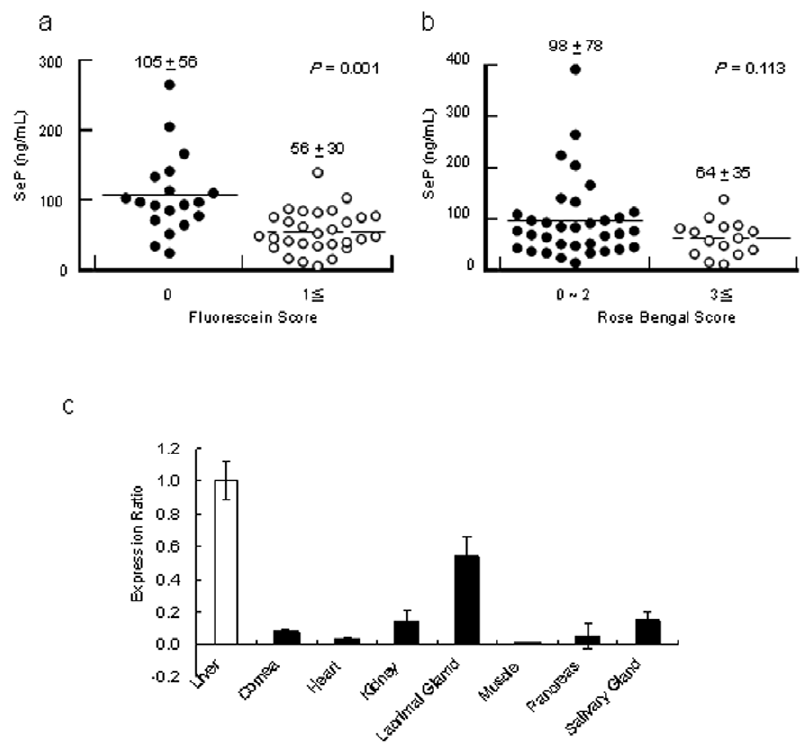
Figure 6. SeP in tears. a, b: Concentration of SeP in human tears. Fluorescein (a) and Rose Bengal (b) Scores are indices of dry eye diagnosis. Dry eye is indicated with fluorescein scores of $ 1, or when the Rose Bengal Score is $ 3. c: SeP expression in rat lacrimal glands. The vertical axis shows expression level of SeP in each tissue compared with liver. The expression level in the liver defined 1. All results are expressed as mean 6 S.D.